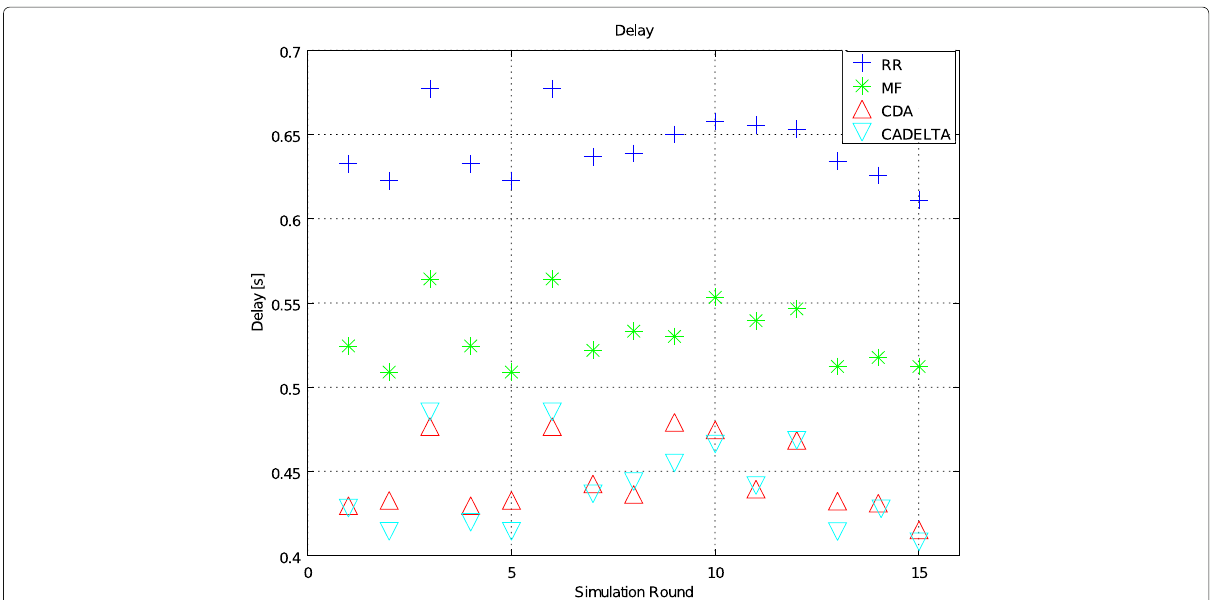
Fig. 14 Delay—traffic monitoring (25%), video surveillance (LQ) (25%) and video surveillance (HQ)